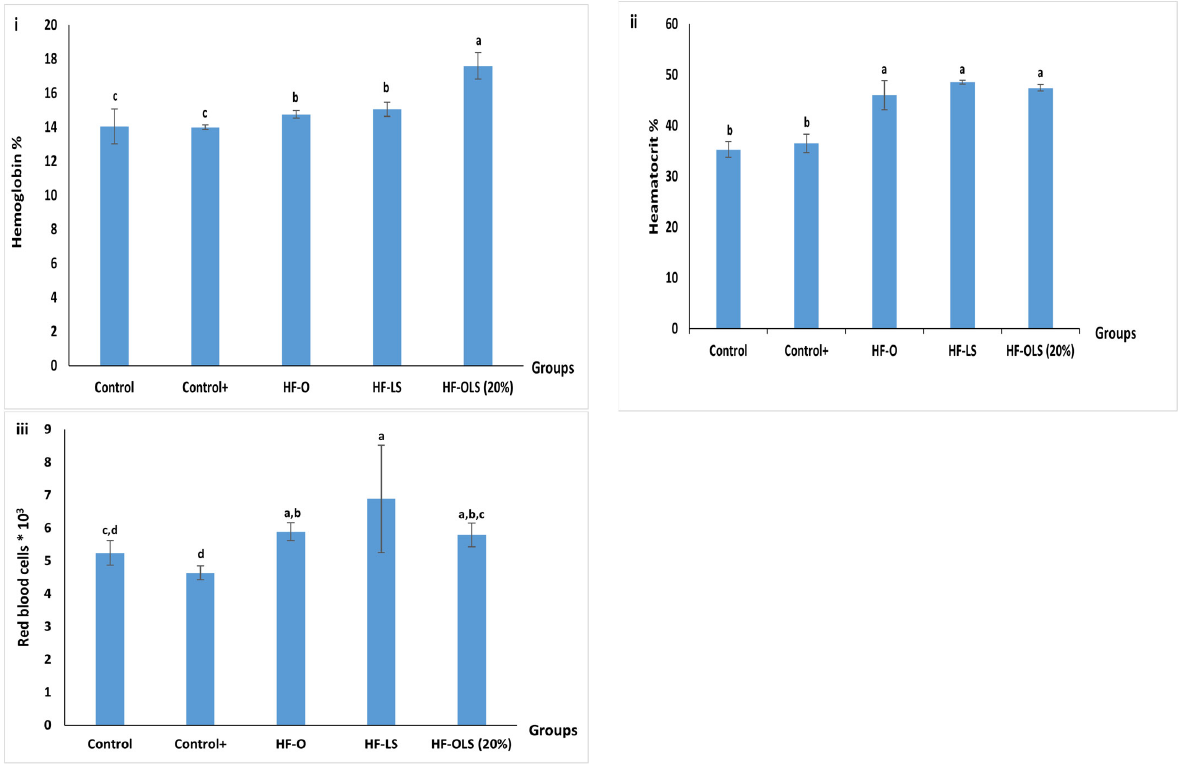
Figure 6. Hematological analysis of rats fed with standard diet, high fat diet, and high fat diet and juice for three months. ( i ): Hemoglobin%, ( ii ): red blood cells (RBCs) *10 3 , and ( iii ): hematocrit%. Control (rats fed with a standard diet), Control+ (rats fed with a high ‐ fat diet composed by mixing standard diet with 20% of vegetarian ghee), HF ‐ O (rats fed with a high ‐ fat diet and 9 mL/kg/day of orange juice), HF ‐ LS (rats fed with a high ‐ fat diet and 9 mL/kg/day of beetroot leaf–stem juice), HF ‐ OLS (20%) (rats fed with a high ‐ fat diet and 9 mL/kg/day of orange juice mixed with 20% of beetroot leaf–stem juice). Columns labeled with different letters are significantly different at p < 0.05.